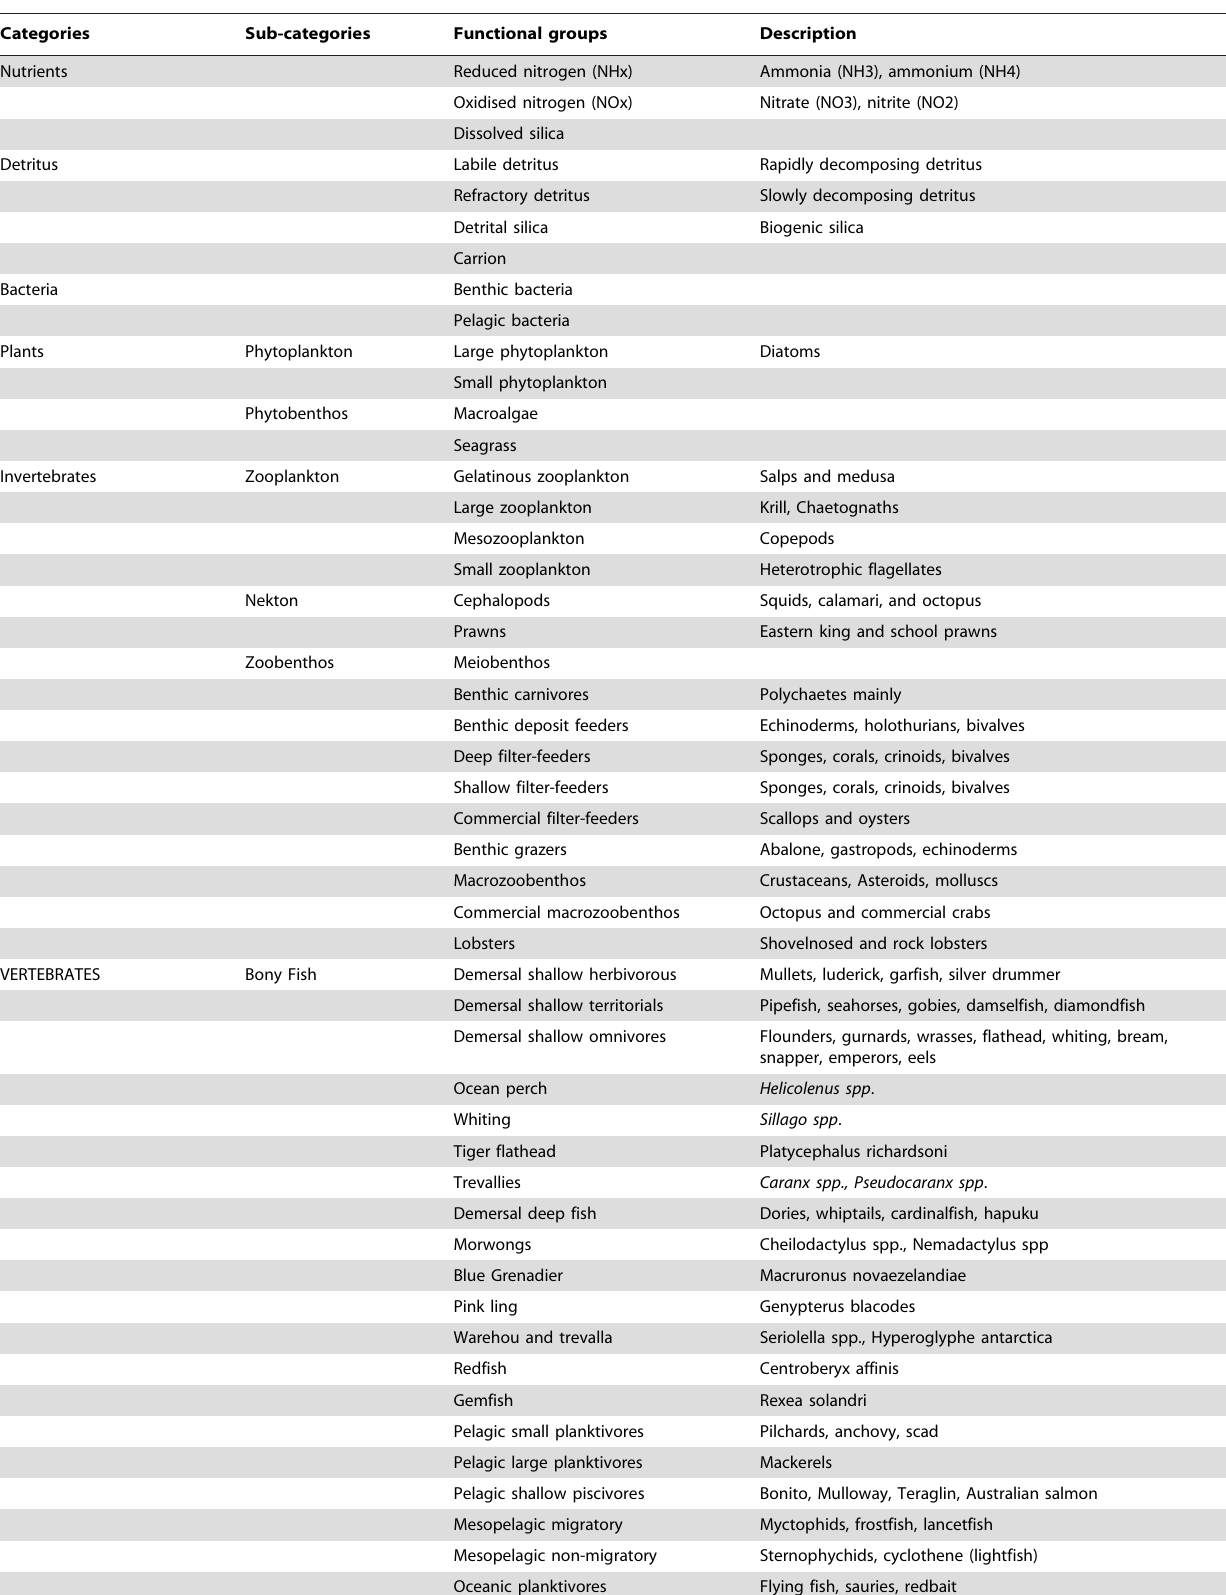
Table 1. Functional groups included in the